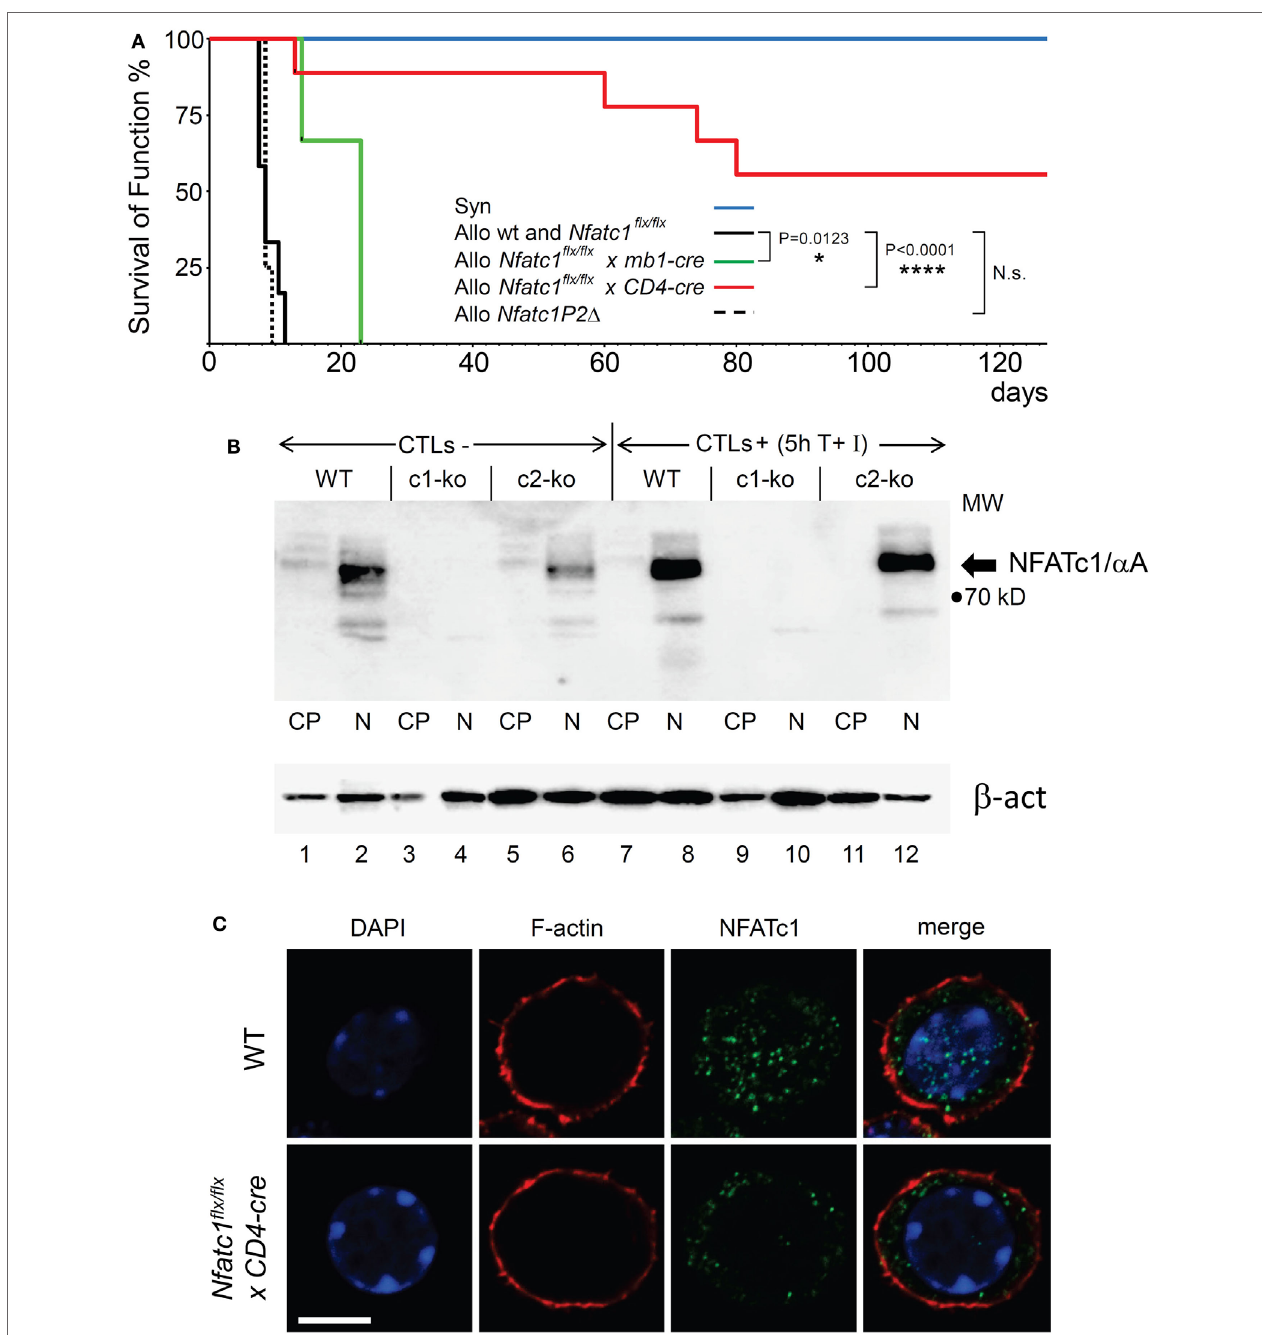
FigUre 1 | NFATc1 deficiency in T cells prevents acute rejection of allogeneic heterotopic heart transplants. (a) Syngeneic (C57BL/6, Syn) or fully allogenic (BALB/c, Allo) heart grafts were transplanted into wild-type (WT) C57BL6, Nfatc1 flx/flx x mb1-cre , Nfatc1 flx/flx x CD4-cre , or Nfatc1P2 Δ recipient mice ( n = 5–9 recipients per group). While Nfatc1 flx/flx x mb1-cre mice bear NFATc1-deficient B cells, Nfatc1 flx/flx x CD4-cre mice bear NFATc1-deficient CD4 + and CD8 + T cells. Nfatc1P2 Δ mice carry an Nfatc1 P2 promoter deletion and, therefore, are deficient for P2-directed transcripts (23). The survival of heart function was monitored daily during the first 3 weeks after transplantation, then four times per week. (B) Representative western blot showing the efficient NFATc1 ablation in cytotoxic T cells (CTL) from Nfatc1 flx/flx x CD4-cre (c1-ko) mice. Cytoplasmic (CP) and nuclear proteins (N) from CTLs of WT, Nfatc1 flx/flx x CD4-cre (c1-ko) and Nfatc2 − / − (c2-ko) mice were fractionated. For the generation of CTLs in vitro , splenic CD8 + T cells were stimulated by α CD3/CD28 antibodies (Abs) for 3 days, followed by culture in IL-2 containing medium for further 3 days. They were left un-induced (CTL-) or induced by T + I (CTL + ) for 5 h (see Materials and Methods). The prominent band of NFATc1/ α A, the inducible, short NFATc1 isoform, is indicated. (c) Staining of splenic CD8 + T cells from WT or Nfatc1 flx/flx xCD4-cre mice activated for 24 h by α CD3/ CD28 Abs in vitro . Cytospins of cells were stained with Abs raised against F-actin or NFATc1 (7A6 mAb), and counter-stained by DAPI. One typical stain of more than 50 cells analyzed is shown. Bar, 10